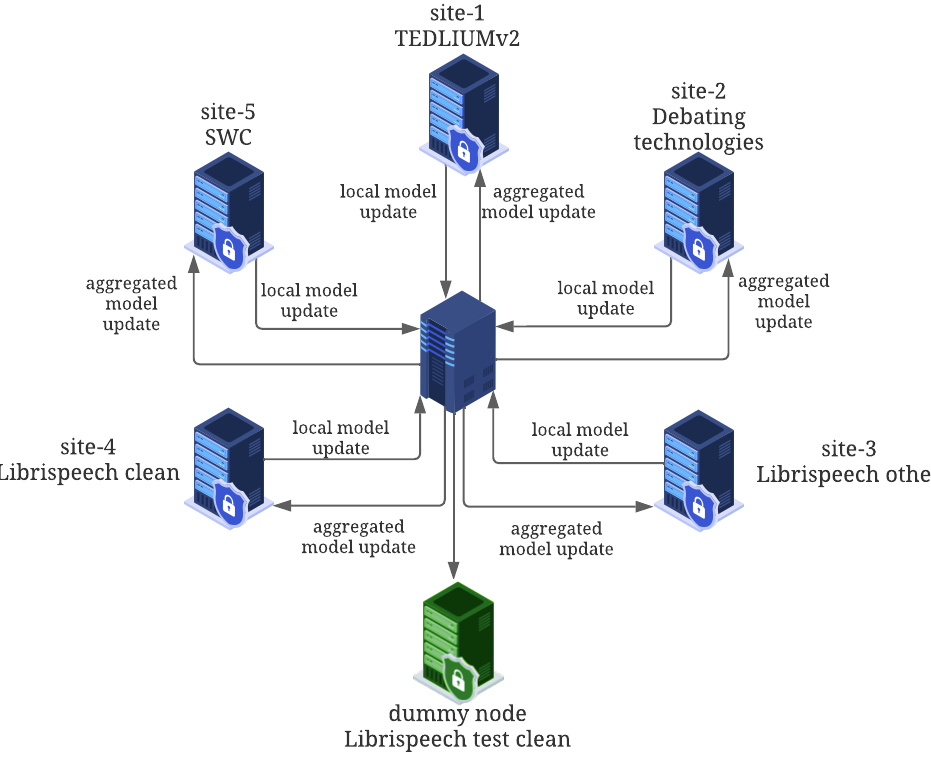
Figure 4. Configuration of the FL architecture. Central server with five client nodes (site- { 1,2, · · · ,5 } ) and a dummy node only used to test the performance of the aggregated